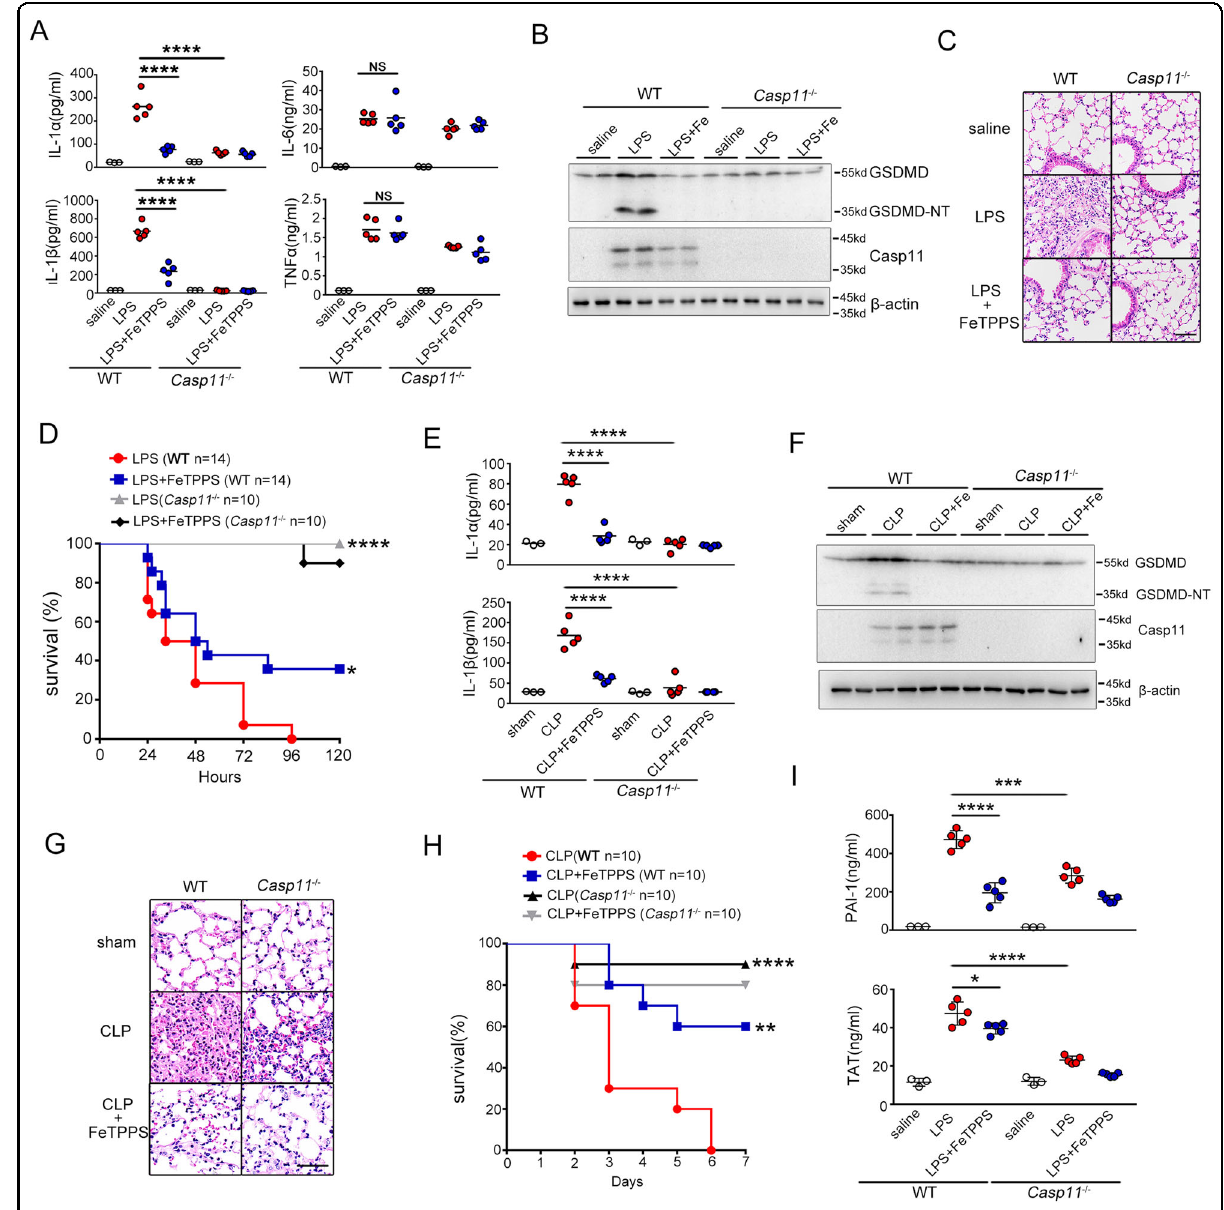
Fig. 3 FeTPPS attenuated caspase-11-dependent immune responses and lethality in sepsis. A – D WT or Casp11 − / − mice were pretreated with FeTPPS 6 mg/kg or saline by intraperitoneal injection 1 h before intraperitoneal challenge with 25 mg/kg LPS. Serum levels of IL-1 α , IL-1 β , TNF α , IL-6 ( A ) (unpaired t -test, n = 5, **** P < 0.0001), western blots for GSDMD-NT, caspase-11 in lung ( B ), hematoxylin and eosin (H&E) stained sections of lung. Scale bar: 50 μ m ( C ) and kaplan – Meier survival curves ( D ). Signi fi cance assessed using Log-rank test: LPS (WT n = 14) vs. LPS + FeTPPS (WT n = 14), * P = 0.0422; WT LPS ( n = 14) vs. Casp11 − / − LPS ( n = 10), **** P < 0.0001. E – H WT or Casp11 − / − mice were pretreated with FeTPPS 6 mg/kg or saline by intraperitoneal injection 1 h before subjected to cecum ligation and puncture (CLP) or sham operation. Serum levels of IL-1 α , IL-1 β ( E ), western blots for GSDMD-NT,Caspase-11 in lung ( F ), hematoxylin and eosin (H&E) stained sections of lung. Scale bar: 50 μ m ( G ) and kaplan – Meier survival curves ( H ). Signi fi cance assessed using Log-rank test: CLP (WT n = 10) vs. CLP + FeTPPS (WT n = 10), ** P = 0.0036; CLP WT ( n = 10) vs. Casp11 − / − ( n = 10), **** P < 0.0001. I WT or Casp11 − / − mice were injected with FeTPPS 6 mg/kg 1 h before intraperitoneal challenge with 25 mg/kg LPS. Plasma concentrations of PAI-1 and TAT were measured. An unpaired t -test was used in PAI-1 LPS(WT n = 5) vs. LPS + FeTPPS (WT n = 5) , **** P < 0.0001; WT LPS ( n = 5) vs. − / − − / − = 0.0001 and TAT Casp11 LPS ( n = 5) *** P LPS (WT n = 5) vs. LPS + FeTPPS (WT n = 5) , * P < 0.0299; WT LPS ( n = 5) vs. Casp11 LPS ( n = 5) **** P <